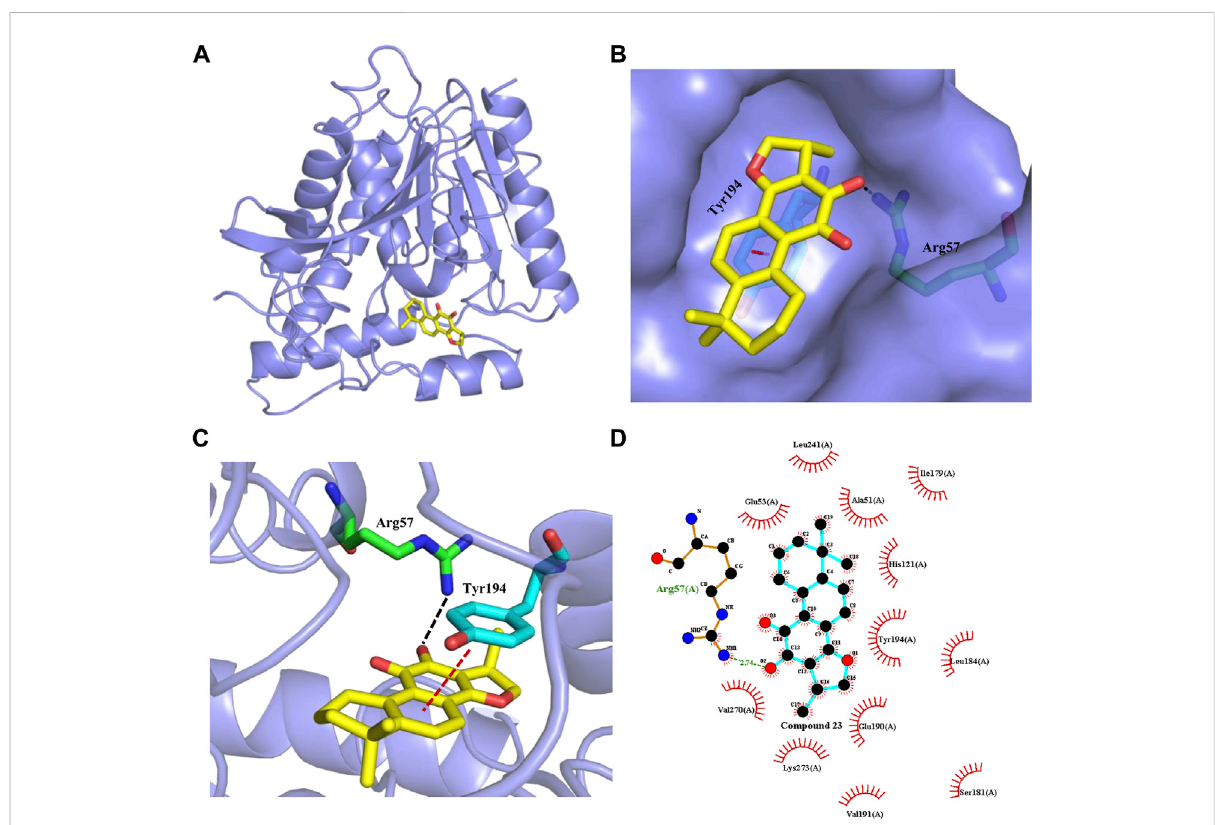
FIGURE 6 Interaction of cryptotanshinone ( 23 , yellow sticks) with human MAGL. (A) Overview of molecule docking of compound 23 into human MAGL (PDB code: 5ZUN, light purple ribbon representation). (B) Surface rendering model showing the disposition of compound 23 (yellow sticks) in a hydrophobic binding pocket of MAGL (light purple). (C) Compound 23 shows the critical interactions with Arg57 and Tyr194. The MAGL domain is shown in ribbon representation. Compound 23 and the residues involved in ligand binding are represented with sticks. The Black dashed line represents a hydrogen bond interaction, while the red dashed line represents a π - π interaction. (D) 2D interaction diagram between compound 23 and MAGL. The ligands and protein sidechains are shown inball-and-stick representations with theligand bonds coloredin sky-blue. The hydrogen bond is shown as green dotted lines, while the spoked arcs represent protein residues making nonbonded contacts with compound 23